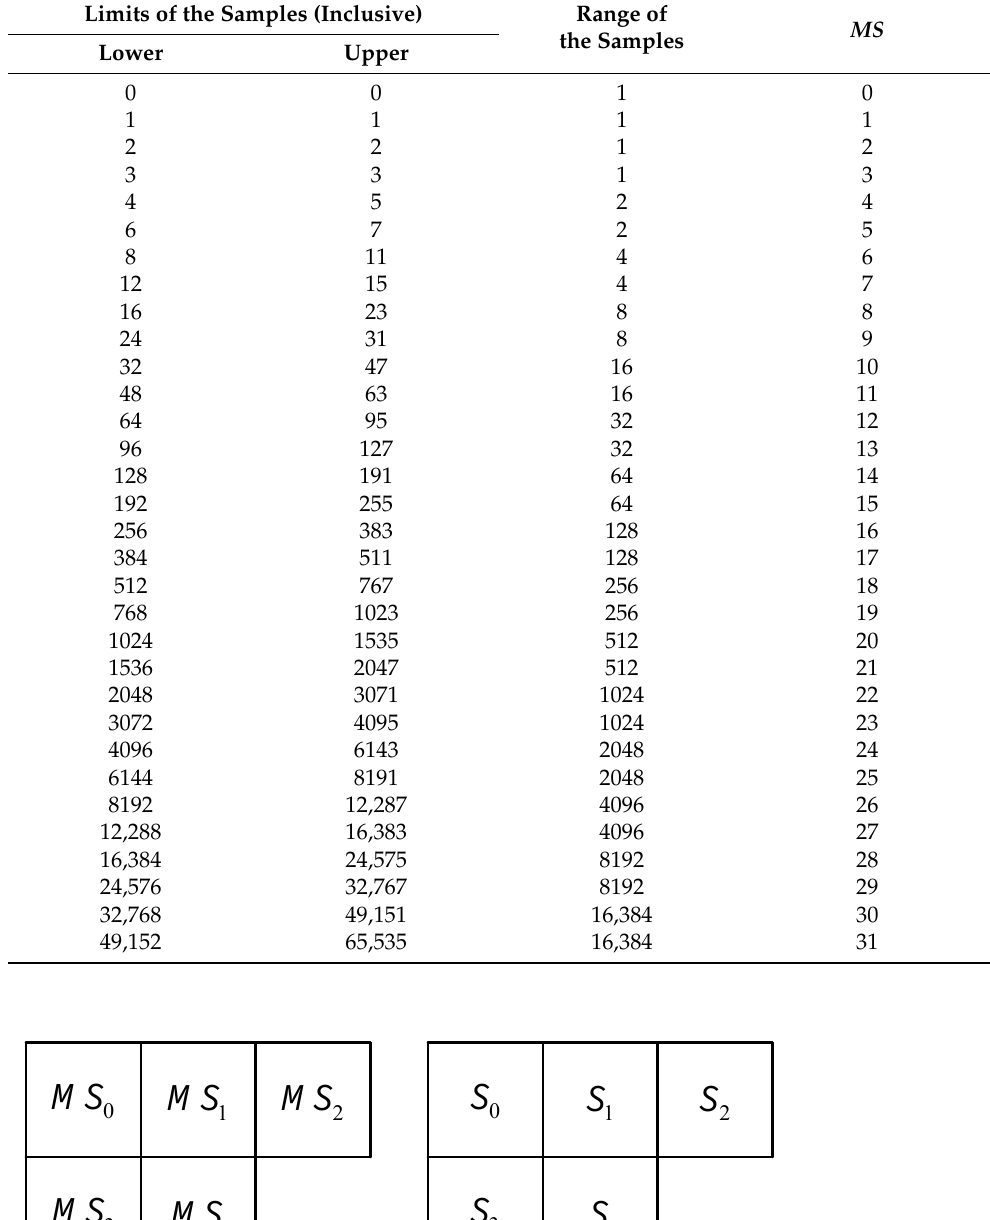
Table 1. Decoding the limit of the samples of the components of the decomposed signal. Limits of the Samples (Inclusive) Range of the Samples